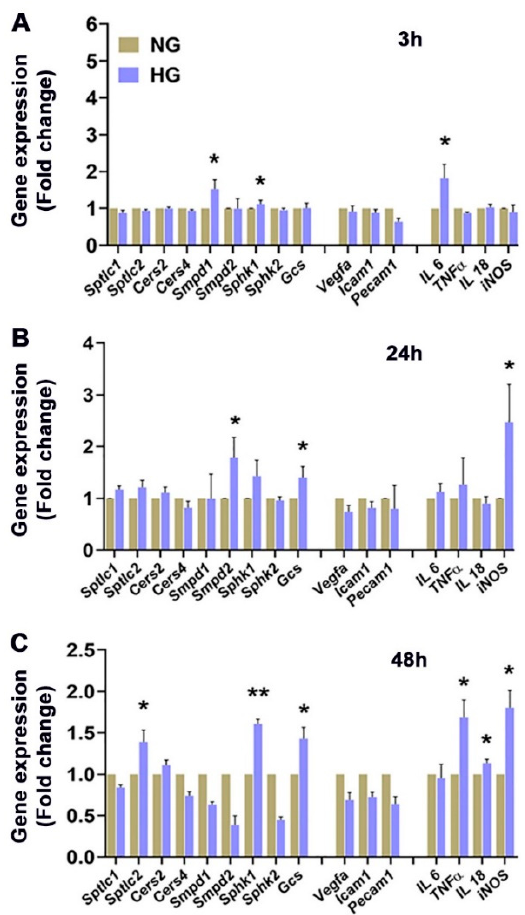
Figure 10. RT-qPCR gene expression analysis of sphingolipid metabolism, vascular proliferation, and inflammatory marker genes in BV2 cells cultured in 5 mM glucose (NG) or 25 mM glucose (HG) conditions for 48 h. Gene expression changes represented as fold change over control (=1.0) following normalization with two housekeeping genes Rpl19 and Gapdh after cells were cultured for ( A ) 3, ( B ) 24, and ( C ) 48 h in NG and HG. Sptlc1 , Sptlc2 , Cers2 , Cers4 , Smpd1 , Smpd2 , Sphk1, Sphk2 , Glucosyl ceramide synthase ( Gcs ); Vegfa , Icam1 , Pecam1, Il6 , Tnf α , Il18 , inducible Nitric oxide synthase ( iNOS ). * p < 0.05, ** p < 0.01; n = 6.